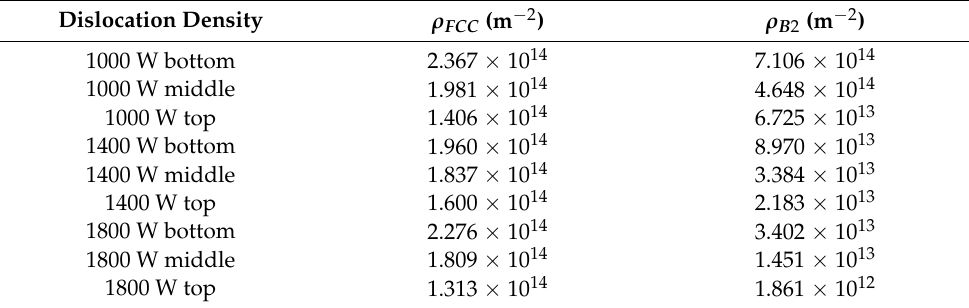
Table 4. The dislocation density ρ in the FCC phase and B2